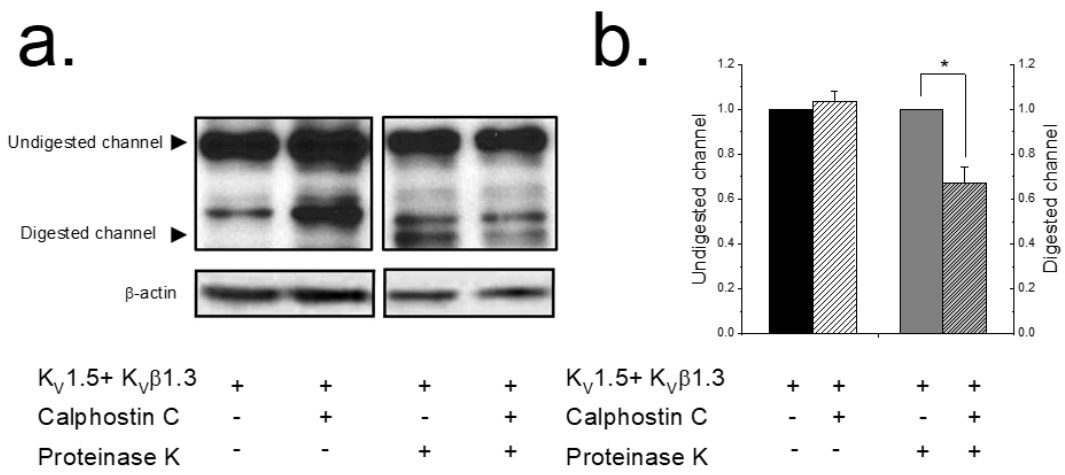
Figure 2. PKC inhibition decreases the K V 1.5–K V β 1.3 levels in the plasma membrane. HEK293 c ells expressing K V 1.5– K V β 1.3 channels treated or not with calphostin C (3 µ M for 2 h). Cells were treated with buffer (lanes 1 and 2) or with proteinase K externally (lanes 3 and 4). Left panel shows a representative experiment ( a ). The two arrows indicate the molecular weight at which digested K V 1.5 (surface channel) and undigested K V 1.5 (intracellular form) appear. β-actin was used as a loading control. Densitometric analysis of 5 experiments as those shown in panel a . Black bars represent, normalized to control, total protein levels; grey bars, normalized to control, proteinase-K-digested K V 1.5–K V β1.3 channel as a representation of plasma membrane levels ( b ). Each value represents the mean ± SEM of five experiments. * p < 0.05.